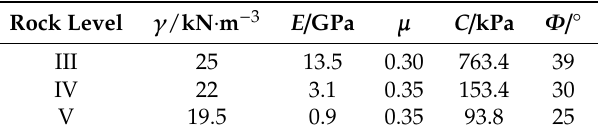
Table 1. Stratum mechanical parameters.